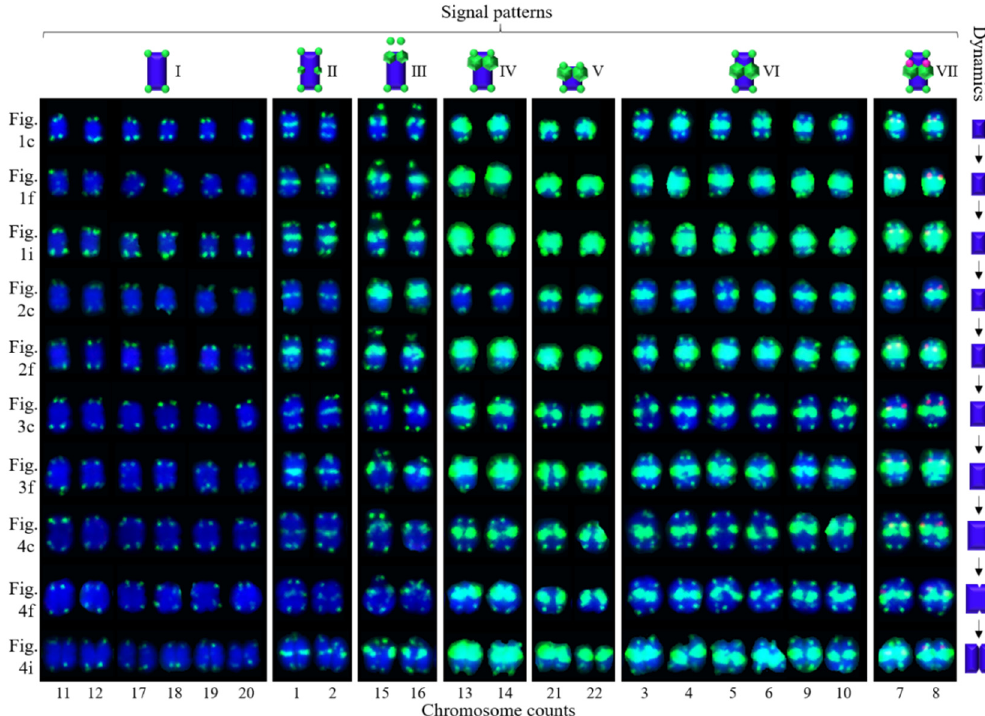
Figure 6. Physical map of Chimonanthus campanulatus . Each chromosome was isolated from Figure 5. The left indicates the origins of each line of chromosomes. The right metaphase dynamic ideograms were constructed based on the metaphase dynamics of chromosomes shown on the left. The signal pattern ideograms at the top were constructed based on the signal patterns of chromosomes. The numbers at the bottom indicate chromosome counts. Chromosomes 15 and 16 are SAT chromosomes.